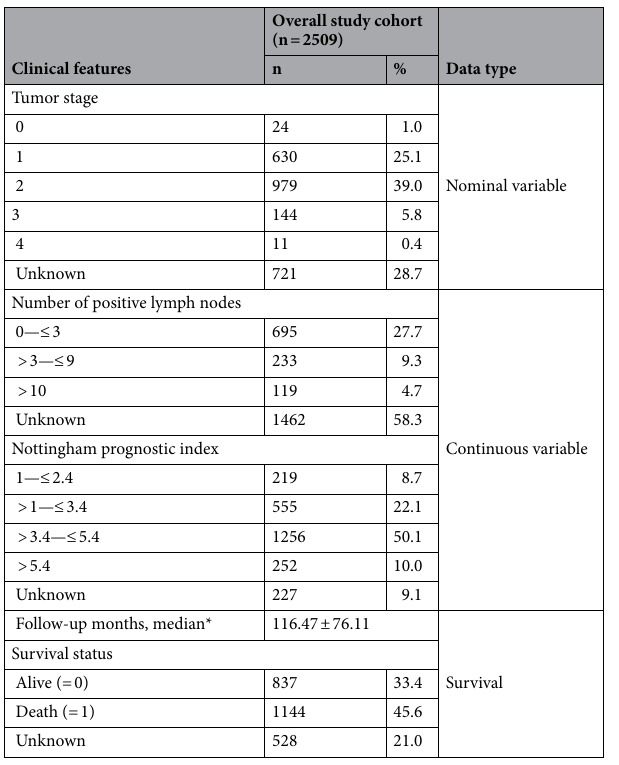
Table 1. Description of the clinical features of the patients included in the study. *Missing information is